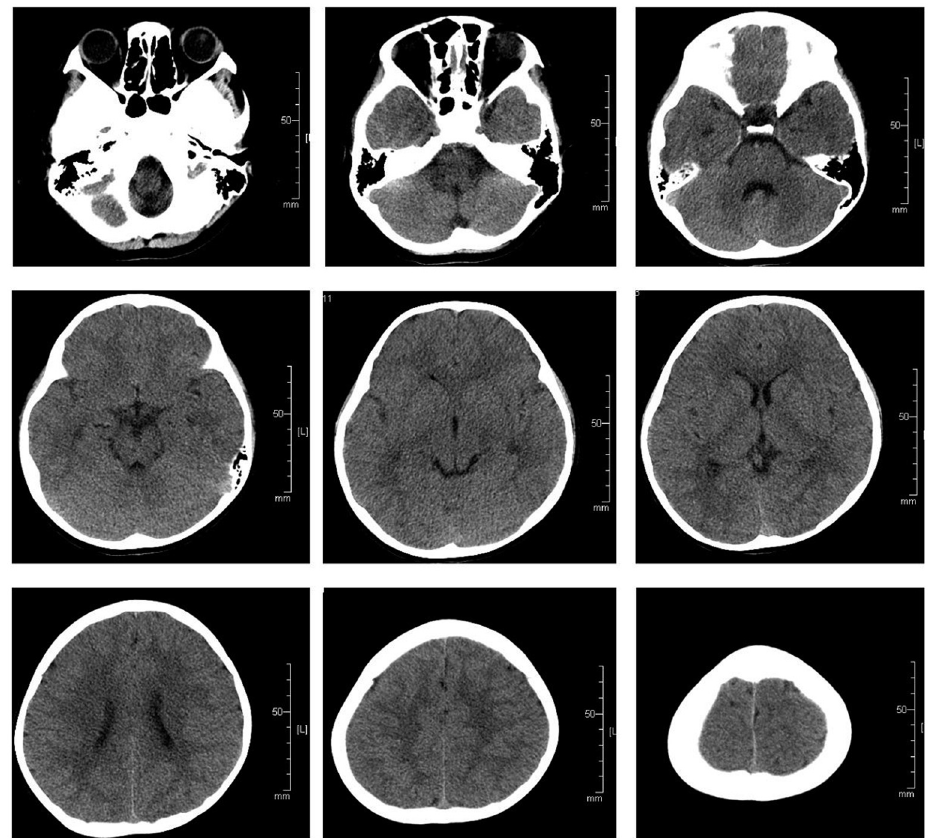
Figure 3. Brain CT of the child after